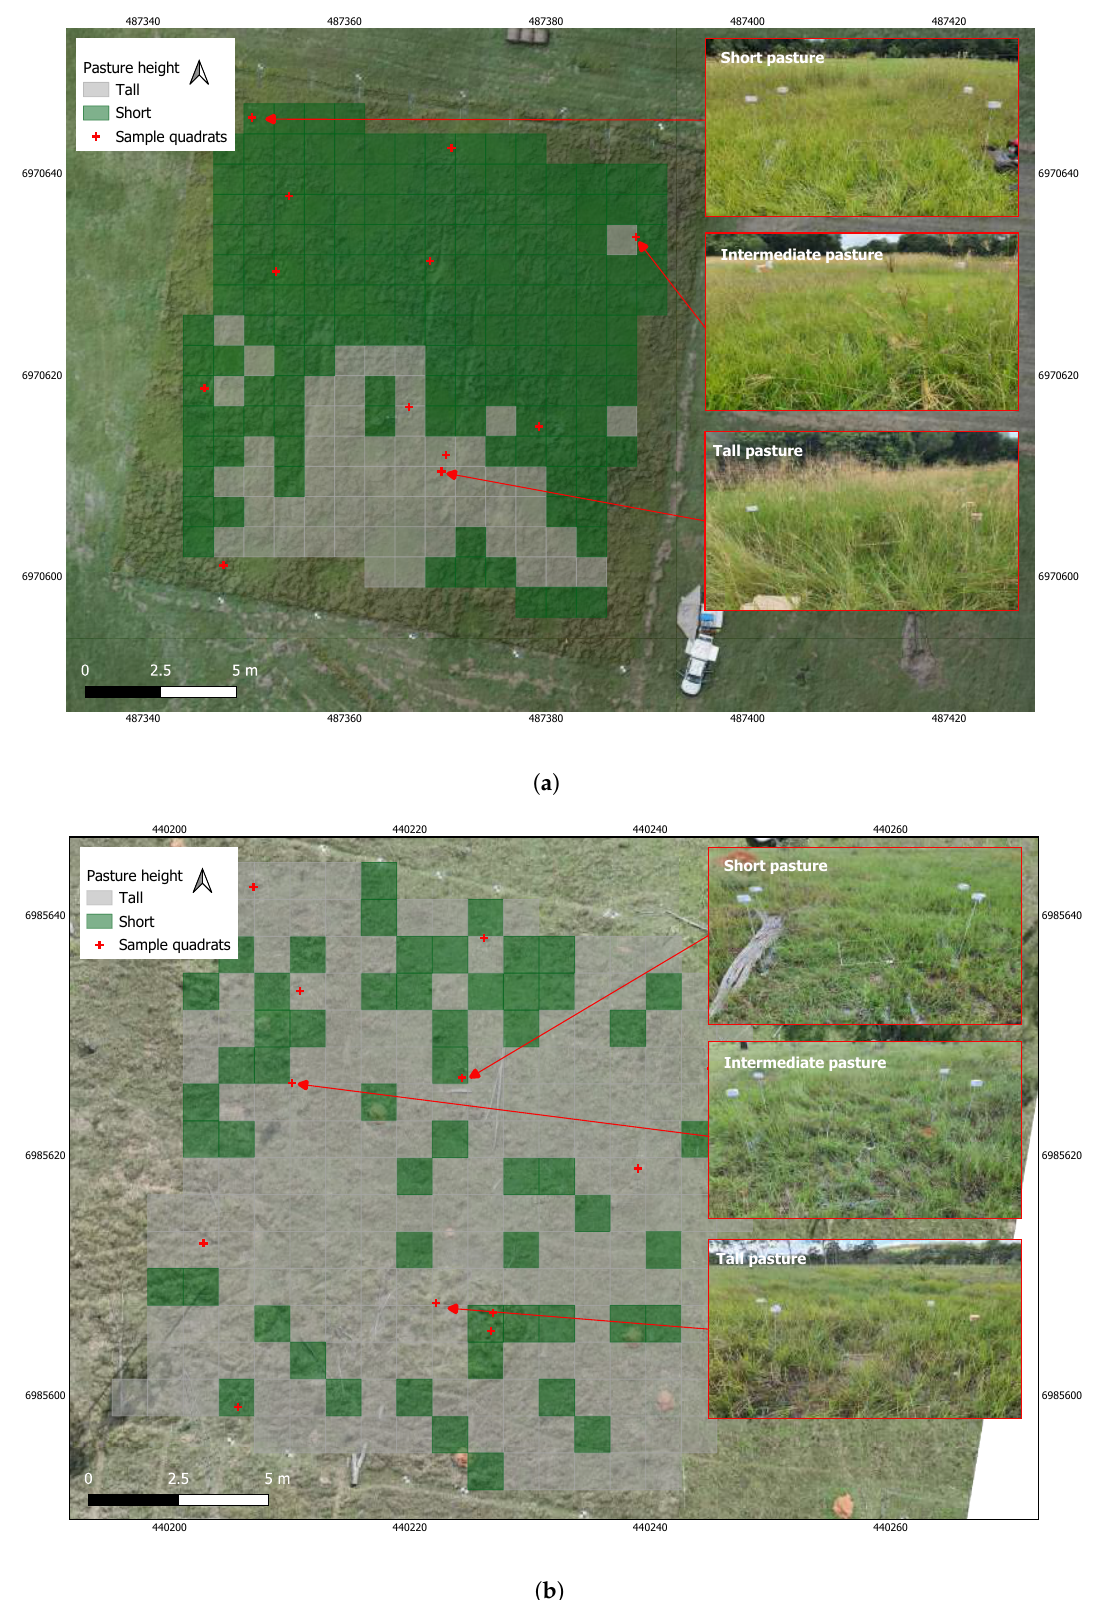
Figure 10. Planet Dove satellite image data scale map of one of the grassland ( a ) and woodland ( b ) field plots, illustrating the stratification of the pasture into tall and short forms.